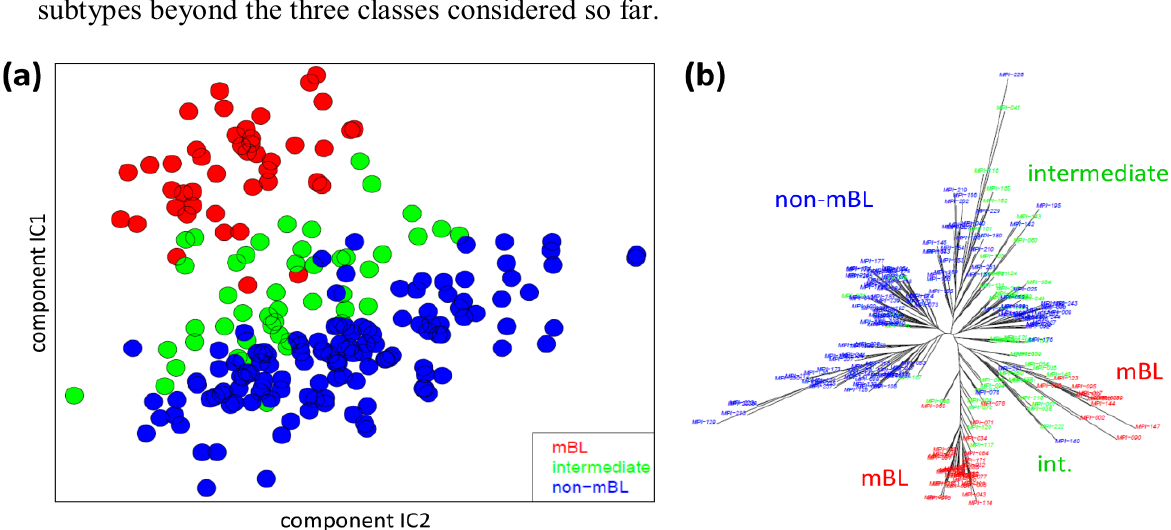
Figure 4. Sample similarity analysis: ( a ) Independent component analysis (ICA) of lymphoma samples. The distribution of the samples is shown in the space spanned by the two leading independent components. ( b ) The neighbor-joining tree projects the sample similarity relations into a dendrogram. The bush-like structures reveal a finer granularity of subtypes beyond the three classes considered so